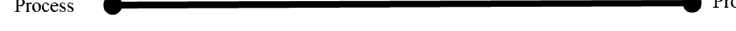
Figure 4. Playing field for evaluating the effectiveness of the public sector.